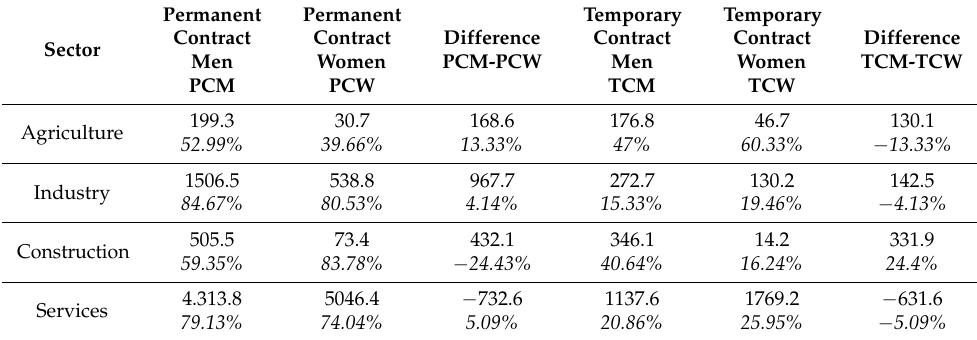
Table 3. Employed by type of contract according to sex, in thousands of people (fourth quarter of 2020).